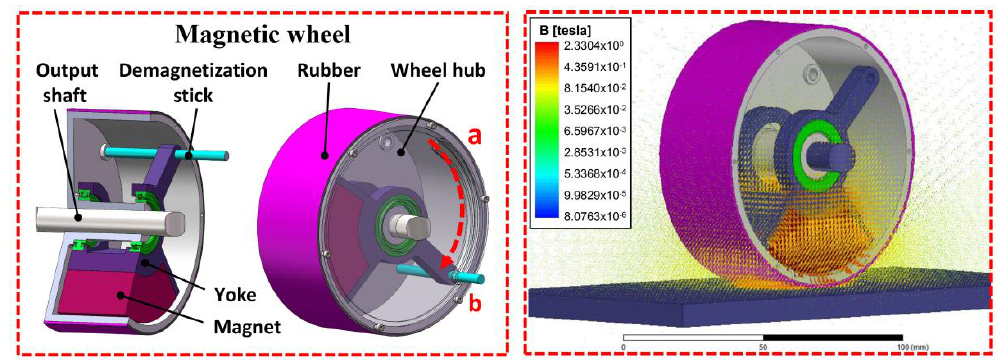
Figure 2. Magnetic wheel structure with fast demagnetization.